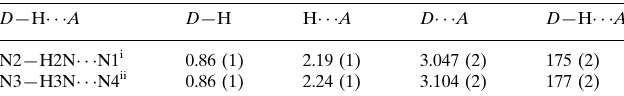
Hydrogen-bond geometry (A˚ , (cid:2)